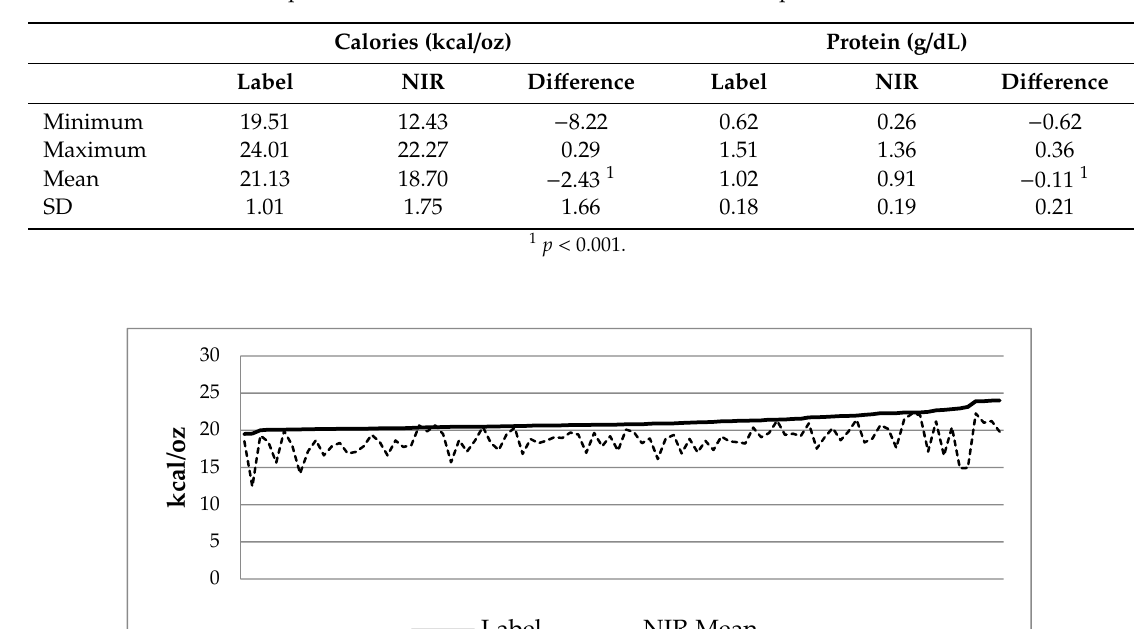
Table 3. Comparison of labeled and NIR measured caloric and protein concentrations.